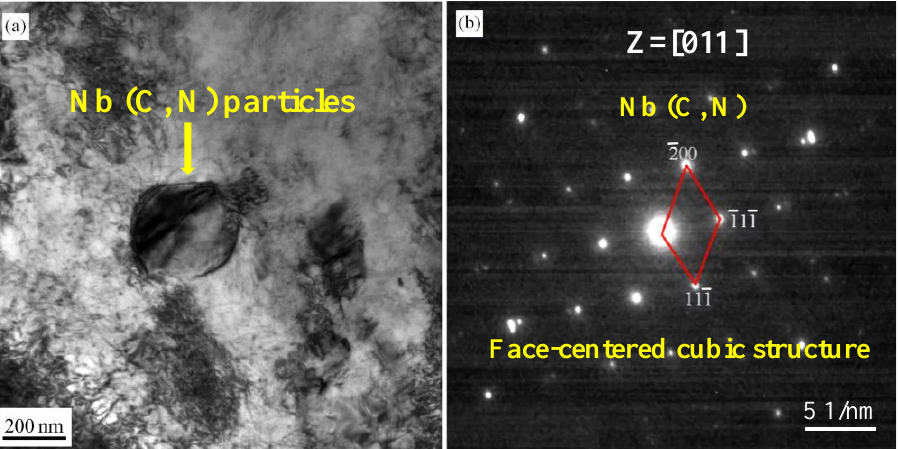
Figure 3. TEM morphology of the steel after solution treatment. ( a ) Bright field image of retained particles, ( b ) diffraction pattern calibration of precipitates.